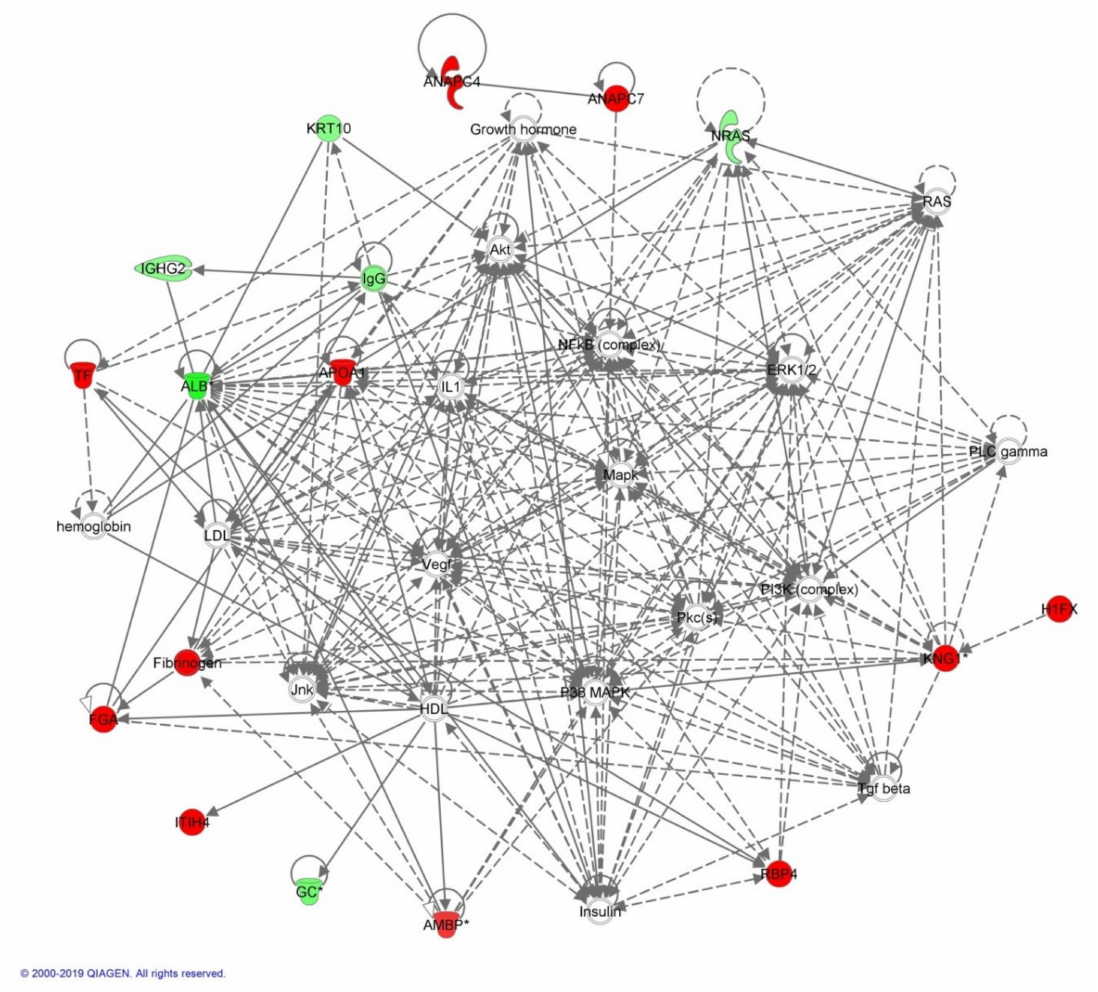
Figure 3. Schematic representation of the most significant Ingenuity Pathway Analysis (IPA) network of di ff erentially regulated proteins in the MHO group compared to those from the MUHO group. IPA analysis indicated a functional interaction of networks, and the highest score of 40 was mostly related to cellular compromise, inflammatory response, and cancer. NF- κ B and p38 mitogen-activated protein (MAP) kinases are indicated as central nodes that were deregulated in MUHO. Nodes in green and red correspond to downregulated and upregulated proteins in MHO vs. MUHO groups, respectively. Uncolored nodes are proposed by IPA and indicate potential targets that were functionally coordinated with the di ff erentially expressed proteins. Solid lines indicate direct molecular interactions, and dashed lines represent indirect